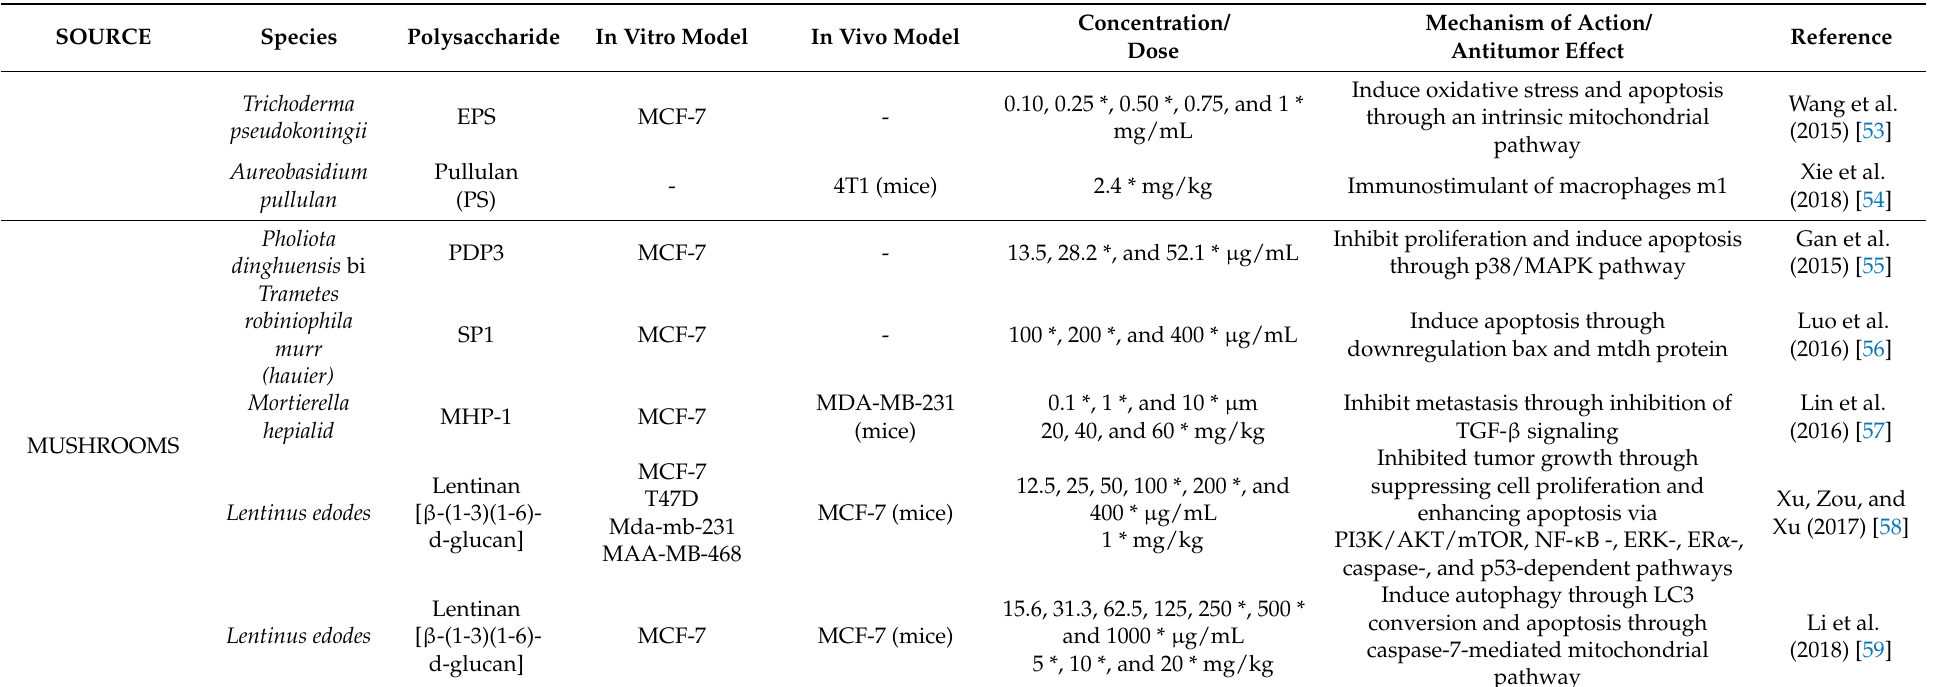
* Represents statistical difference indicated by the author of the study in relation to the control of the experiment. AP-1, activator protein 1; APS, astragalus polysaccharide; Se-PFPs, Se-enriched P. fortuneana; CAP, Capsicum annuum polysaccharide fraction; COX-2, cyclooxygenase 2; DMBA, 7,12-dimethylbenz(a)anthracene; EPS, exopolysaccharide isolated from the fermentation liquor of Trichoderma pseudokoningii fungus; ERK, extracellular signal regulated protein kinase; HIF1A, Polymorphic variation of hypoxia inducible factor-1 A; IGF-1, insulin-like growth factor-1; JNK, c-Jun N-terminal kinase; LBPs, Lycium barbarum polysaccharides; LC3, 1A/1B-light chain 3; LMWF, low molecular weight fucoidan; MAPK, mitogen-activated protein kinase; MMP-9, matrix metalloproteinase-9; NF- κ B, factor nuclear kappa